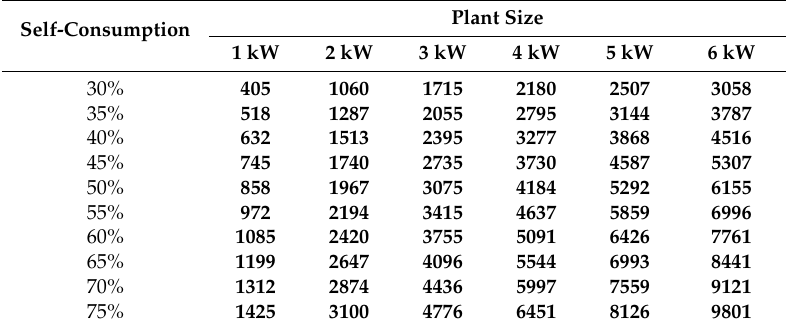
Table 8. Net Present Value ( € ) of residential PV systems with a new policy of fiscal deduction.